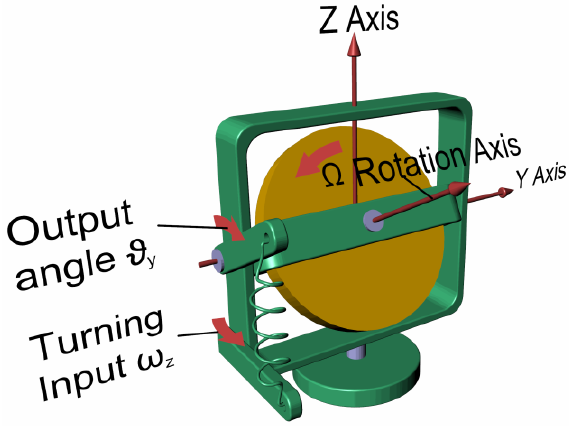
Figure 3. Mechanical rate gyroscope.